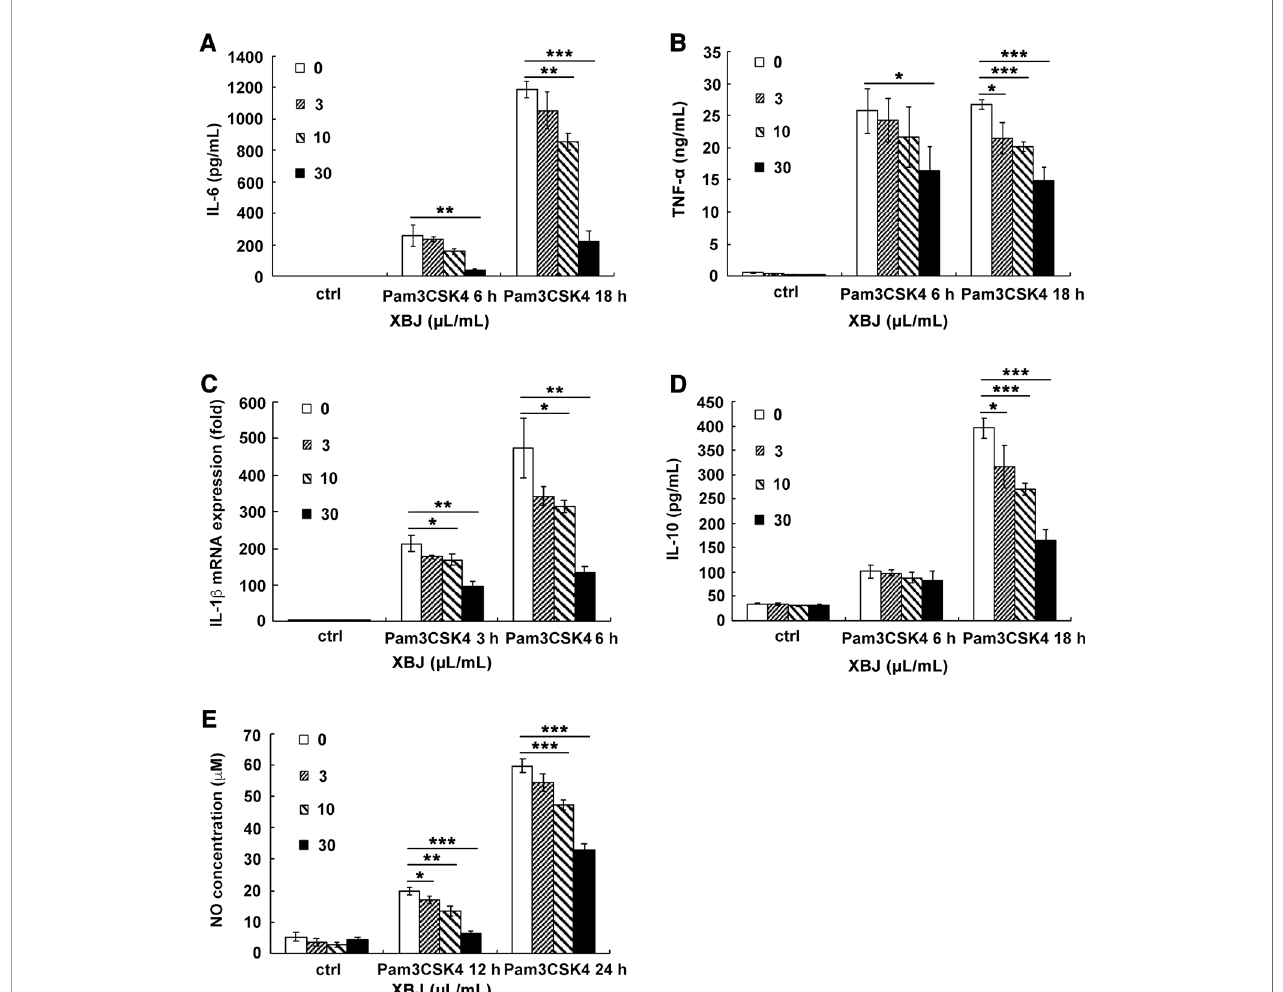
FIGURE 6 | XBJ inhibited the production of Pam3CSK4-induced in fl ammatory mediators in Raw264.7. Raw264.7 cells were seeded (2 × 10 5 cells/well) in 24-well plates overnight and stimulated by Pam3CSK4 (100 ng/ml) with different concentrations of XBJ for 6 or 18 hours. Cell culture supernatants were collected and the concentrations of IL-6 (A) , TNF- a (B) , and IL-10 (D) were measured by ELISA. IL-1 b (C) mRNA expression was examined by qRT-PCR. NO concentrations (E) was measured by Griess assay at 12 or 24 hours after stimulation. Data were shown as mean ± SD (n=3). * , ** , ***Signi fi cantly different at p < 0.05, p < 0.01, and p < 0.001,